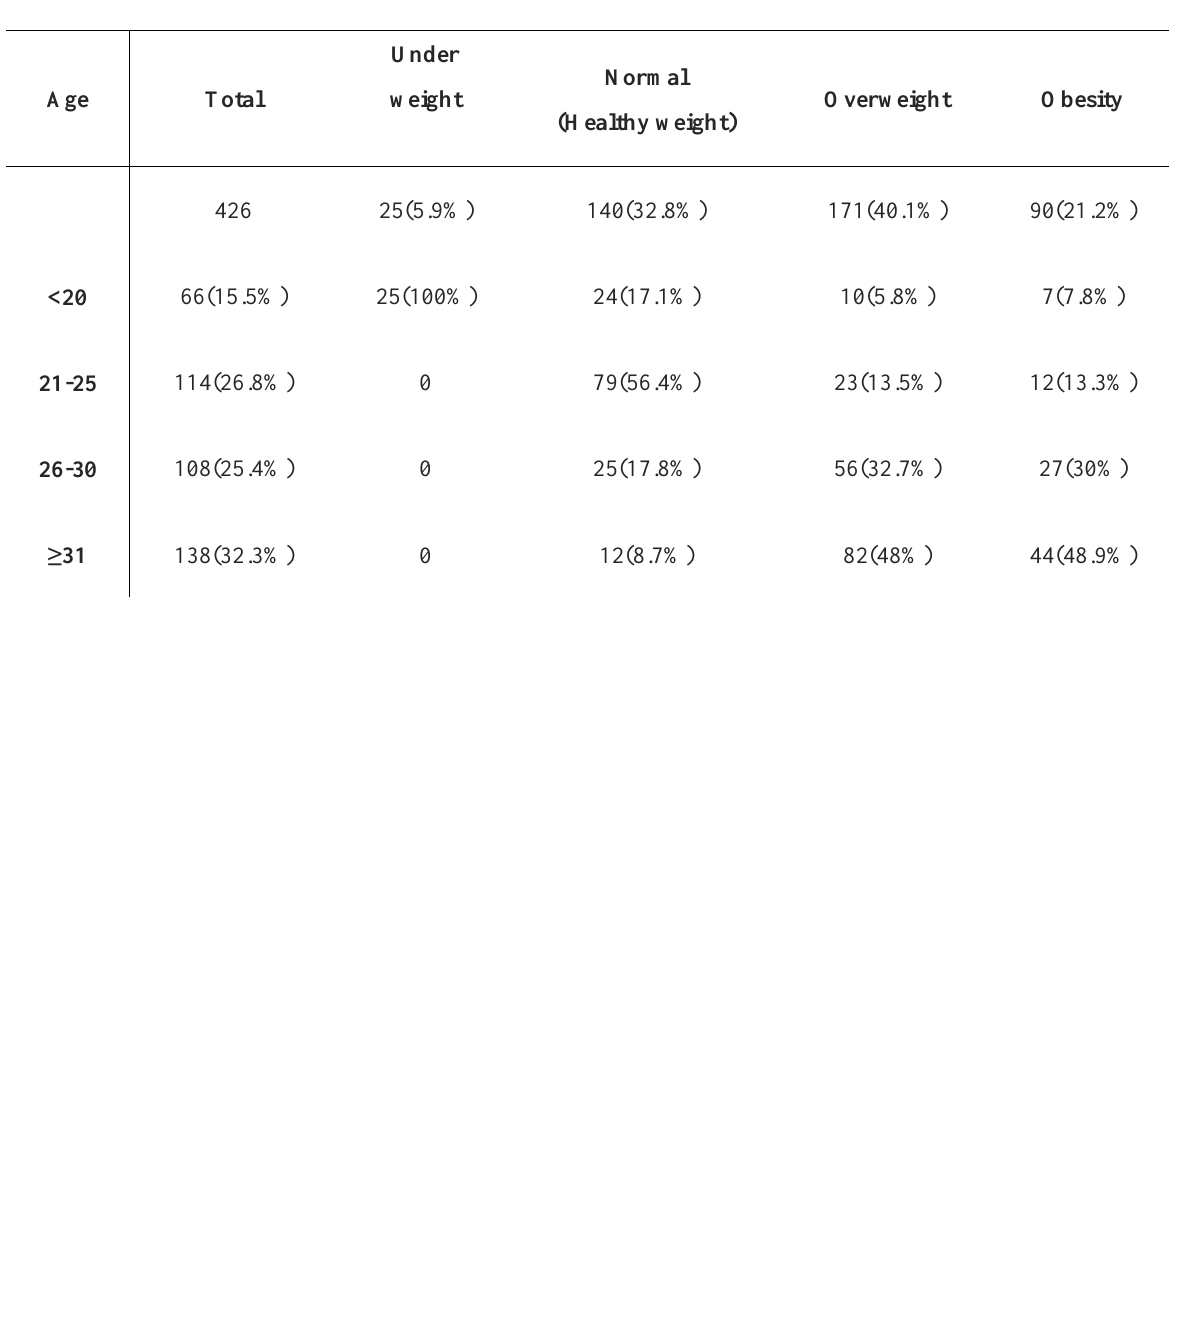
Table 1: Distribution of respondents by age and BMI